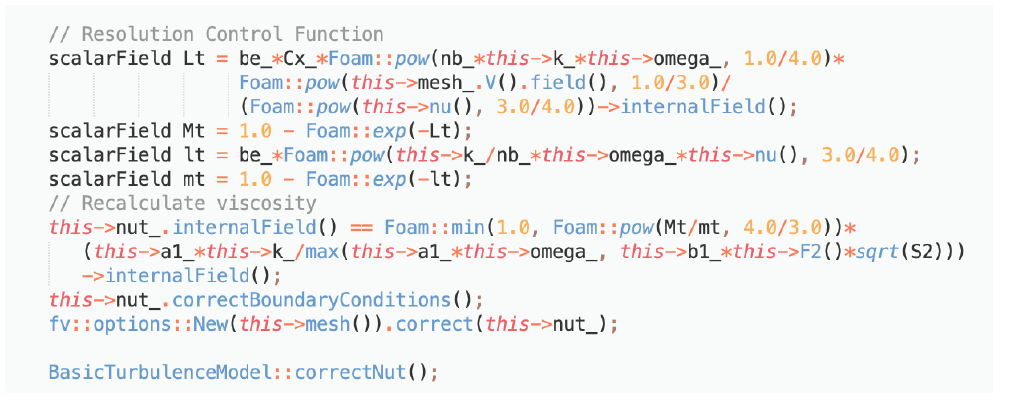
Figure 9. Turbulent viscosity scaled by Resolution Control Function.